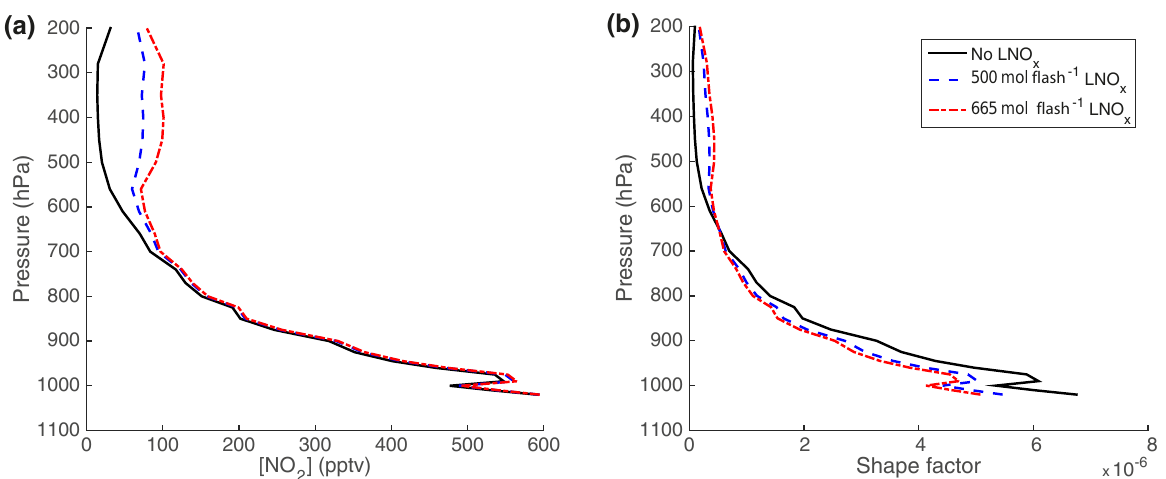
Figure 1. Domain-wide mean WRF-Chem NO 2 profiles. (a) Profiles in mixing ratios; (b) profiles in shape factor as defined in Palmer et al. (2001), i.e., number density divided by VCD. LNO x is lightning NO x .